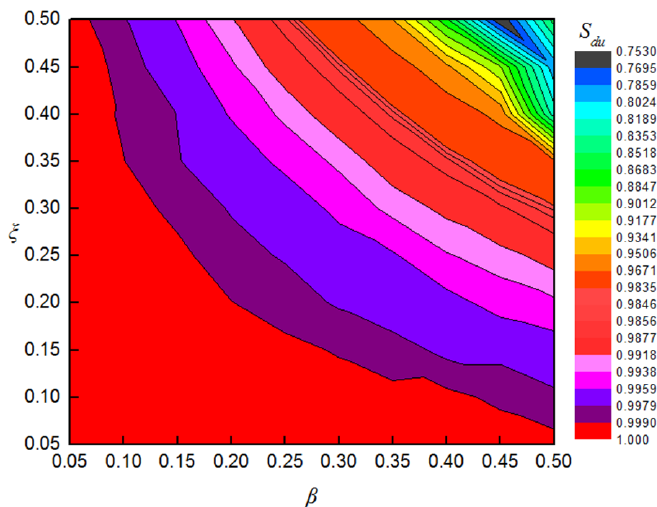
S with β and ξ . rl